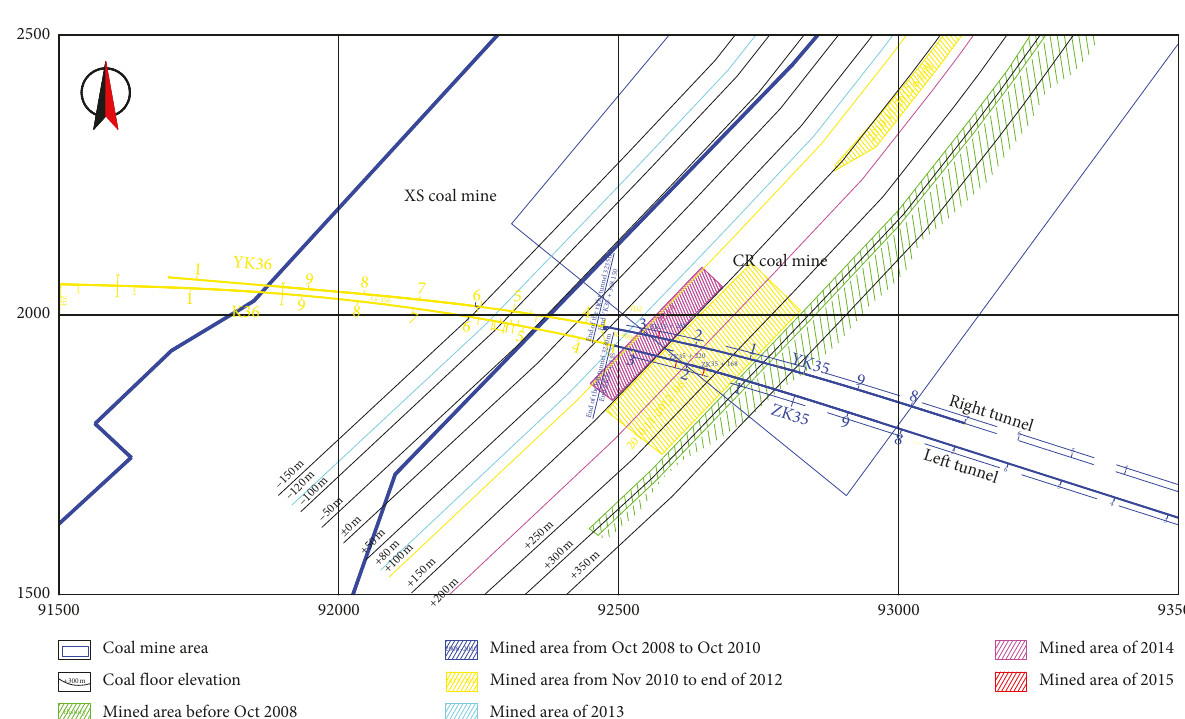
Figure 7: Coal mined area of K